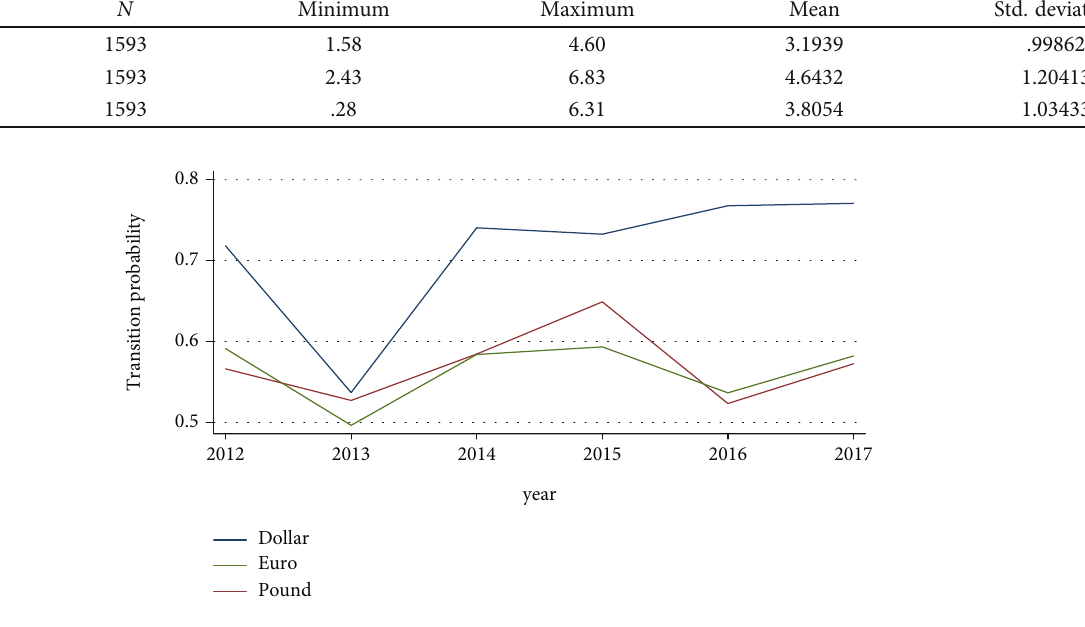
Figure 1: Plots of probabilities of transitions ð 1 ⟶ 1 Þ for the study period by exchange rate. Notes: ð 1 ⟶ 1 Þ means one-step transition frequencies from increase to increase.